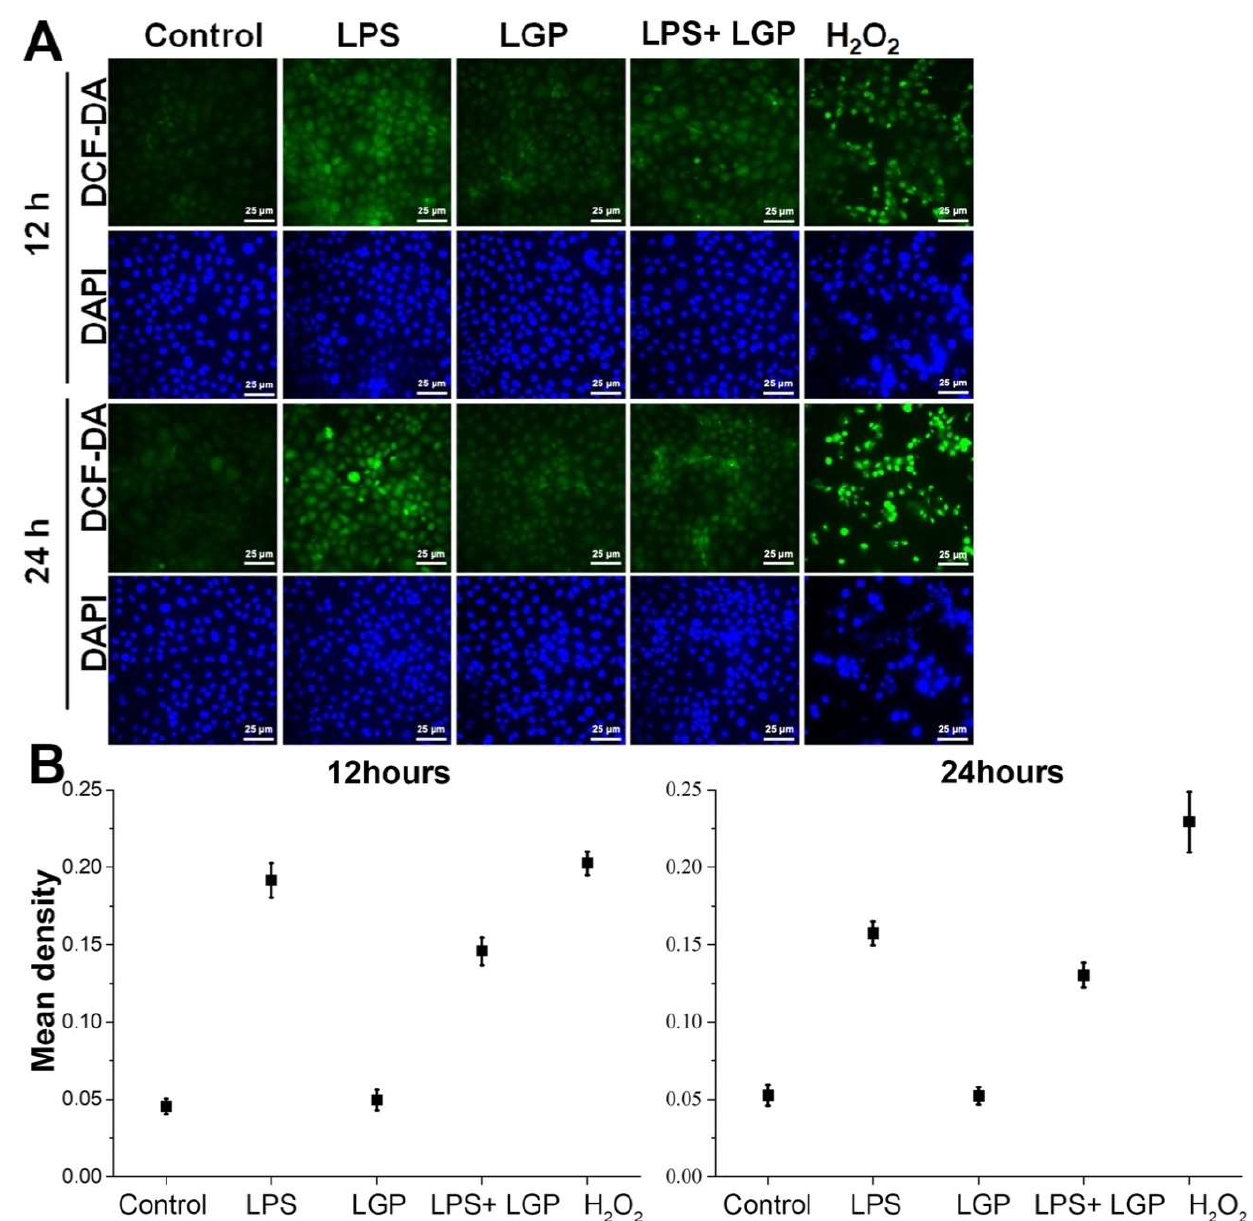
Figure 1. Reactive oxygen species (ROS) assay of NRK-52E cells after 12 or 24 h incubation with/without 10 μg/mL lipopolysaccharide (LPS) or 0.1 μg/mL linagliptin (LGP), using 2′,7′-dichlorodihydrofluorescein diacetate (DCF-DA) as a fluorescent probe and 4′,6-diamidino-2-phenylindole dihydrochloride (DAPI) to stain the nuclear acid. ( A ) 0.1 μg/mL linagliptin attenuated ROS induced by 10 μg/mL LPS in NRK-52E cells. ( B ) Semi-quantitative results of the ROS production by software ImageJ 1.47t.